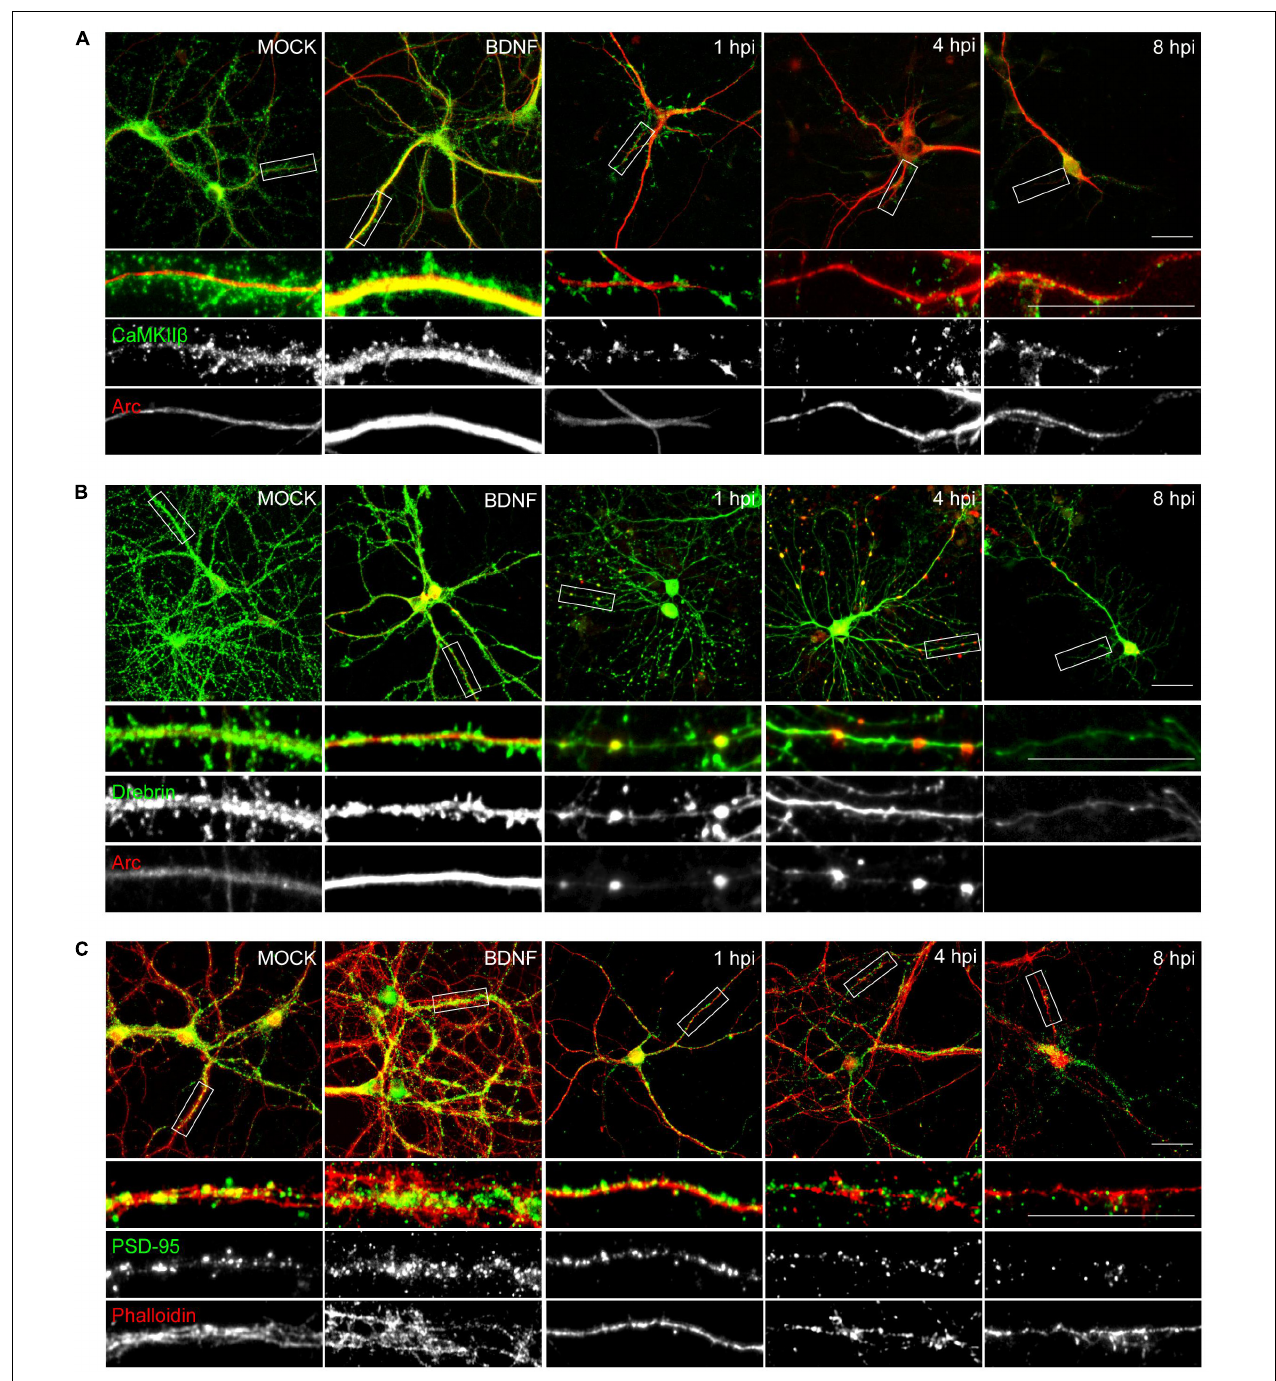
FIGURE 4 | HSV-1 neuronal infection alters the normal distribution of Arc, CaMKII β , Drebrin and PSD-95. Immunocytochemistry analyses of infection kinetics. BDNF was used as a positive control for synaptic protein expression. Double staining against (A) Arc and CaMKII β ; (B) Arc and Drebrin; (C) PSD-95 and cytoskeleton probe: Phalloidin (red). Secondary antibodies coupled to Alexa Fluor 488 and 568. Bars: 20 mm. The results shown are representative of three independent experiments.